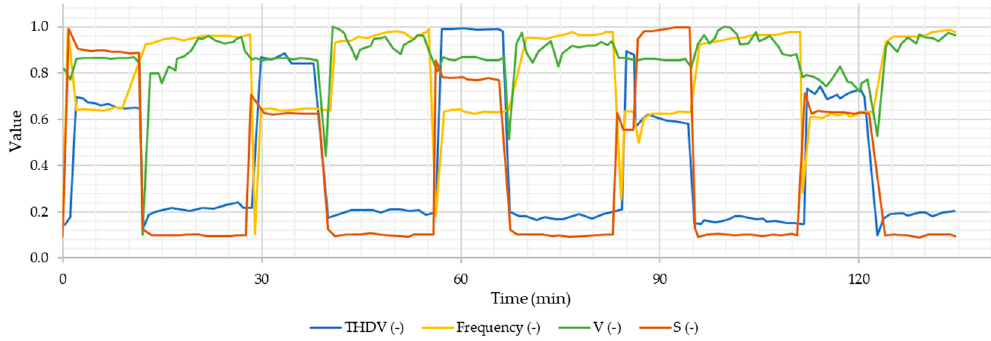
Figure 4. Sample of PQ parameters time plot shows the load and charging phase.